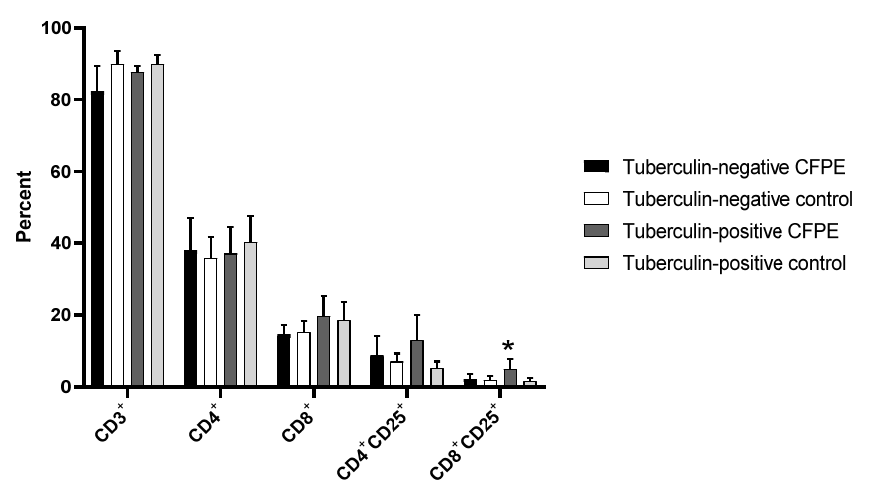
Figure 3. T lymphocyte subpopulations identified with Panel 1 in PBMCs from tuberculin-positive and tuberculin-negative heifers. Cells were cultivated for three days. * p < 0.05.